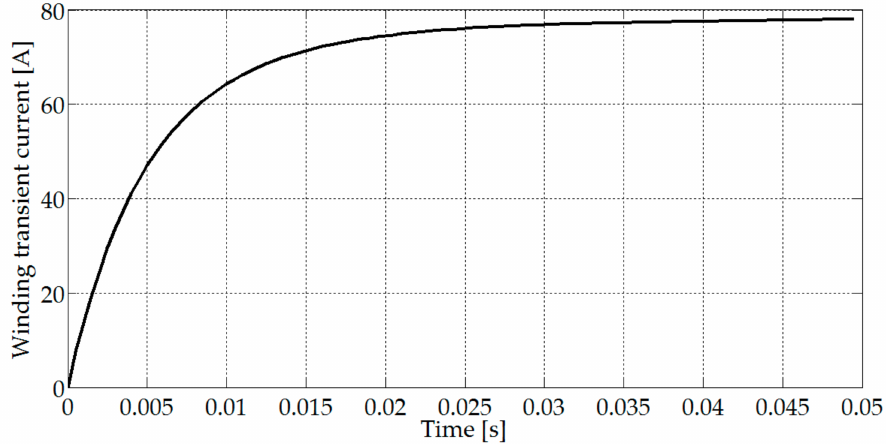
Figure 7. Winding transient